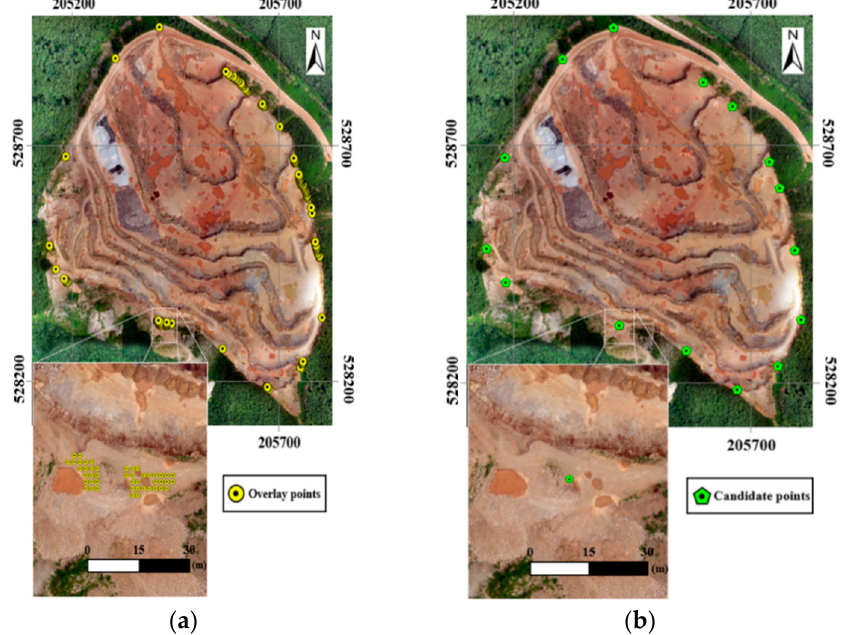
Figure 7. Results of selecting ( a ) 181 points satisfying four conditions and ( b ) the final 15 transmitter candidate points in the study area.